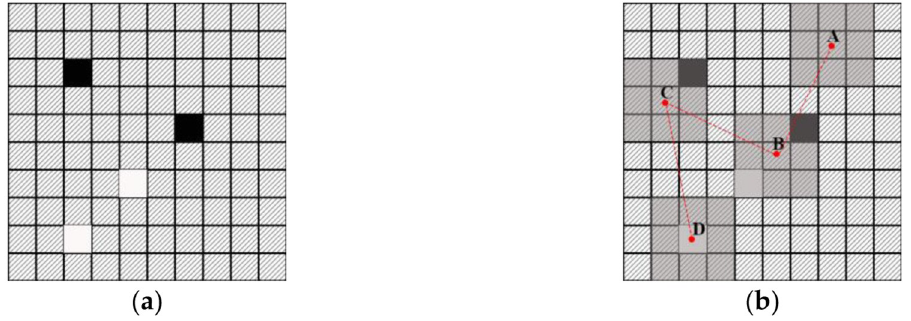
Fig 6. Repeated simulation of grid nodes (the red dotted line represents a random